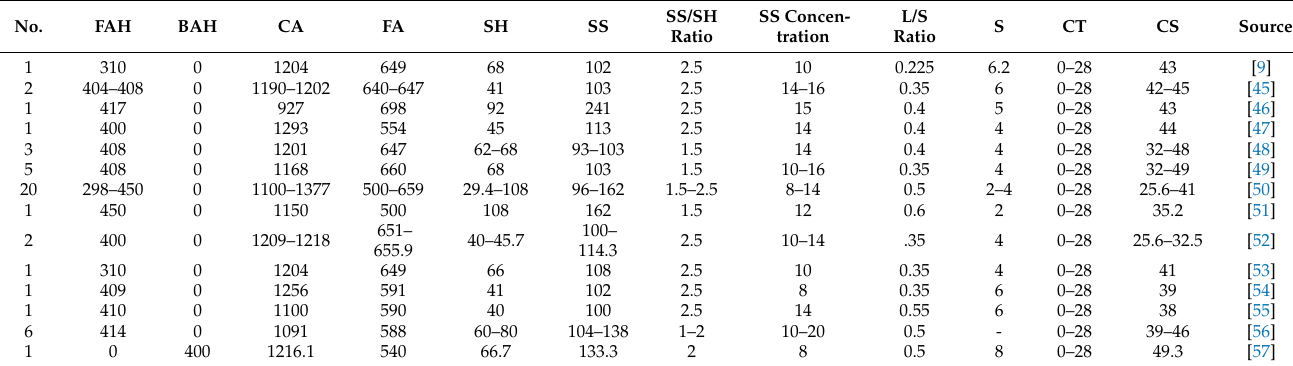
Table 2. Details of data and their